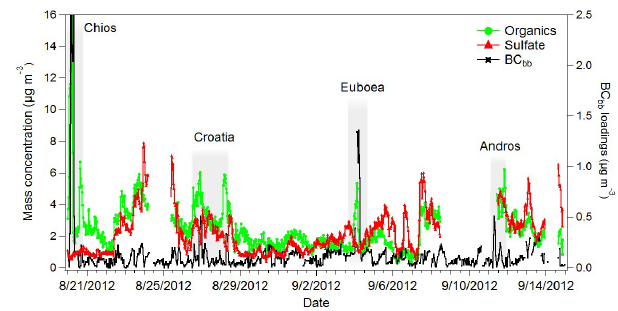
Figure 3. Time series concentrations of major PM 1 species that contribute in the identification of the BB events. The shaded areas represent the four considered fire